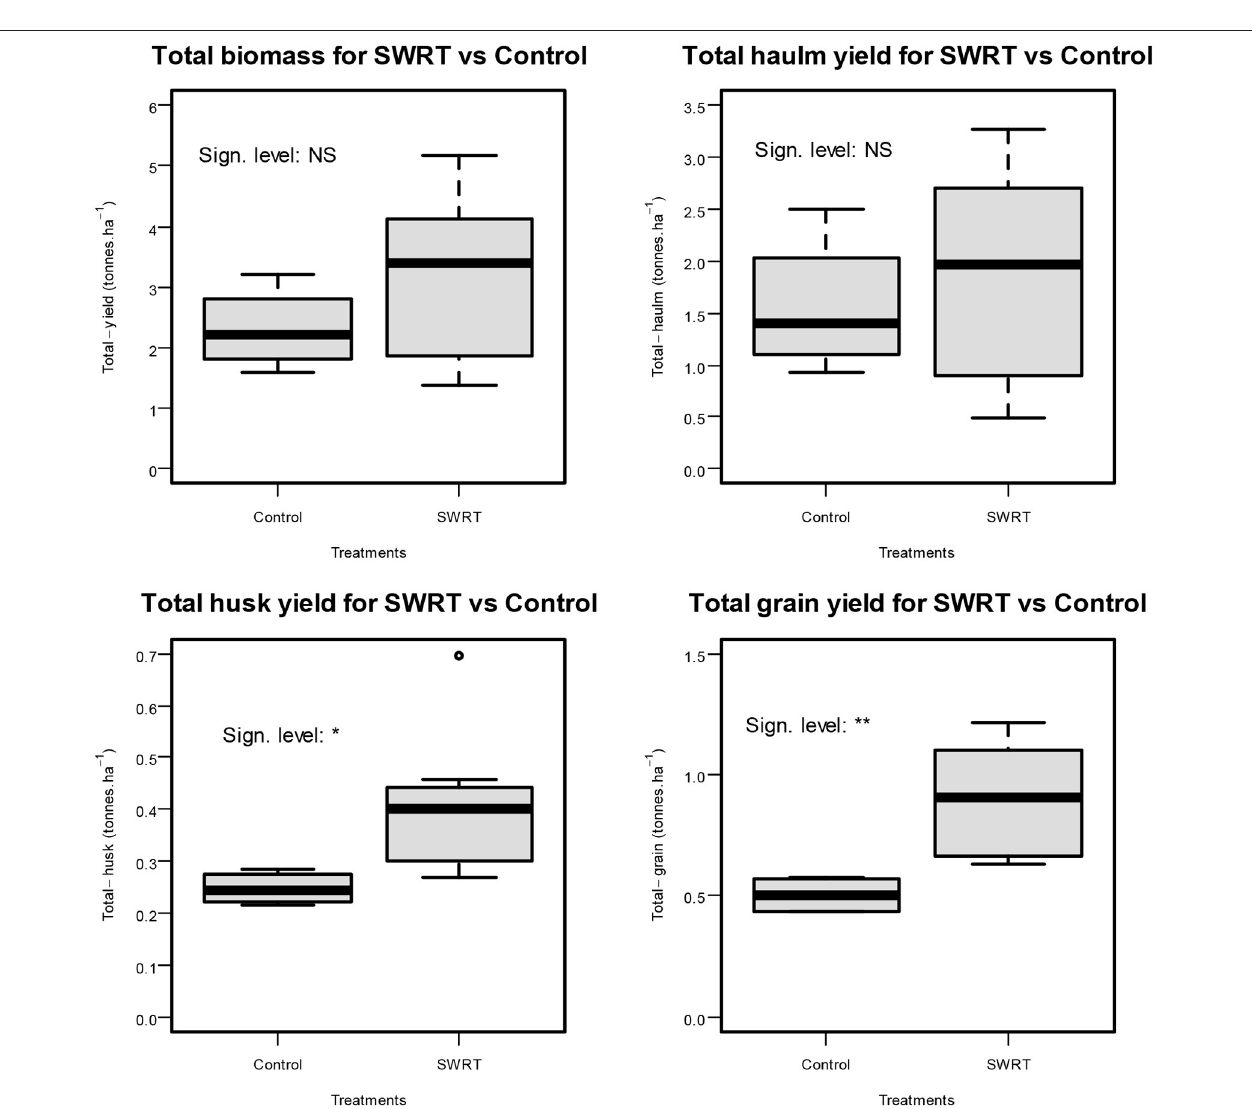
FIGURE 5 | Yield at harvest in sub-surface water retention technology (SWRT) plots and control plots of whole cowpea biomass (sum of haulm, husk, and grain) and of cowpea haulm, husk, and grain. “Sign. level” in each panel denotes the level of significance of differences between SWRT and control plots (** p < 0.01, * p < 0.05, NS p >